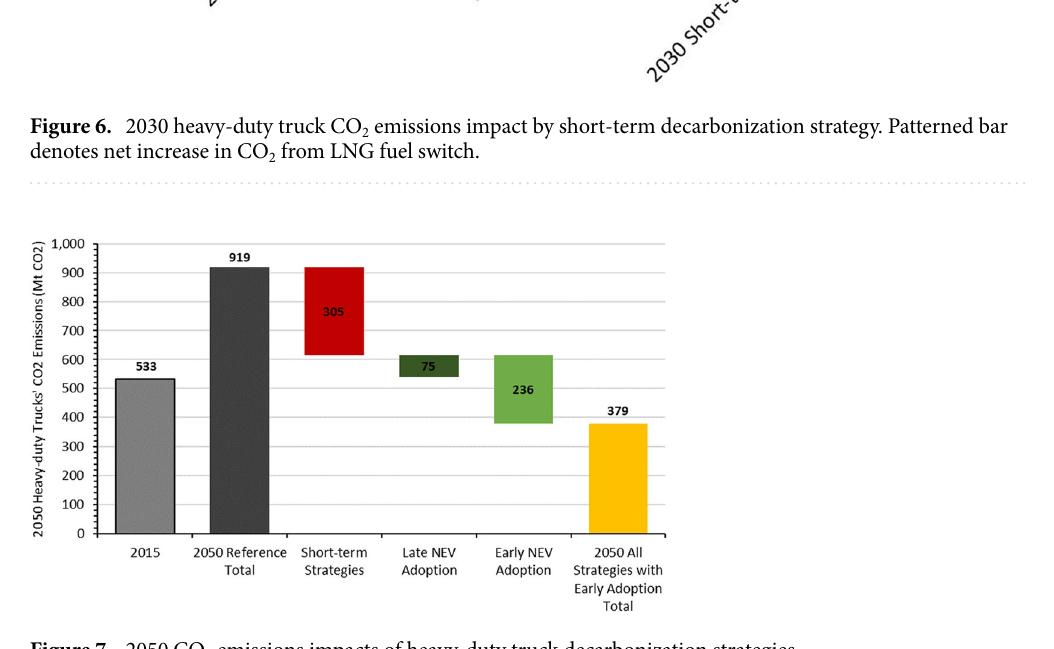
Figure 7. 2050 CO 2 emissions impacts of heavy-duty truck decarbonization